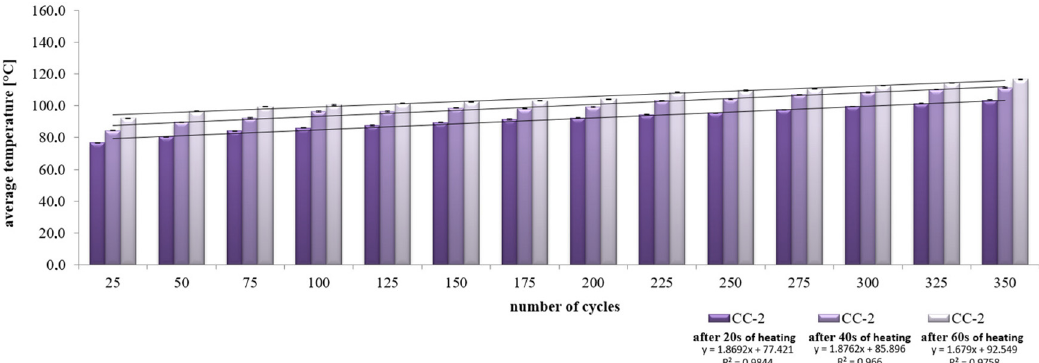
Figure 15. Change in the average temperature of CC-1 concrete during the heating process.